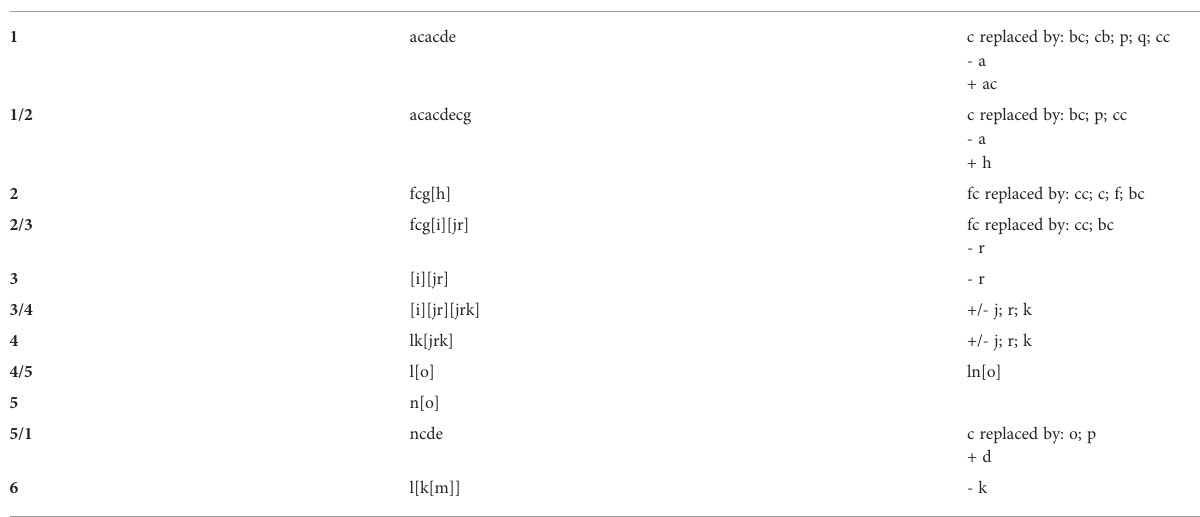
TABLE 1 Unit sequences of phrase types. Phrase Type Characteristic Unit